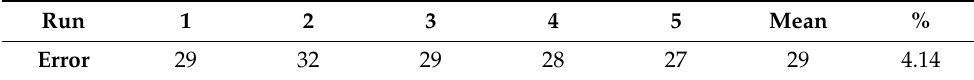
Table 6. Error of each experiment.